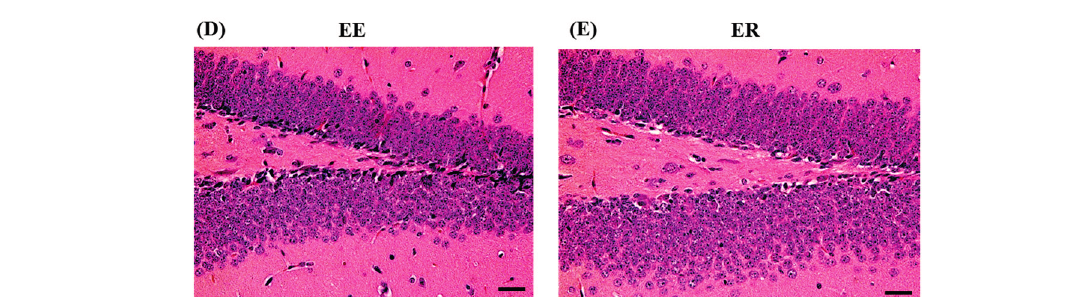
Figure 4. Representative photomicrographs showing the histology of the hippocampal DG region in ( A ) CC, ( B ) SC, ( C ) EE, ( D ) ES, and ( E ) ER groups (H&E staining) in 7-week-old male mice. Scale bar = 50 μ m.